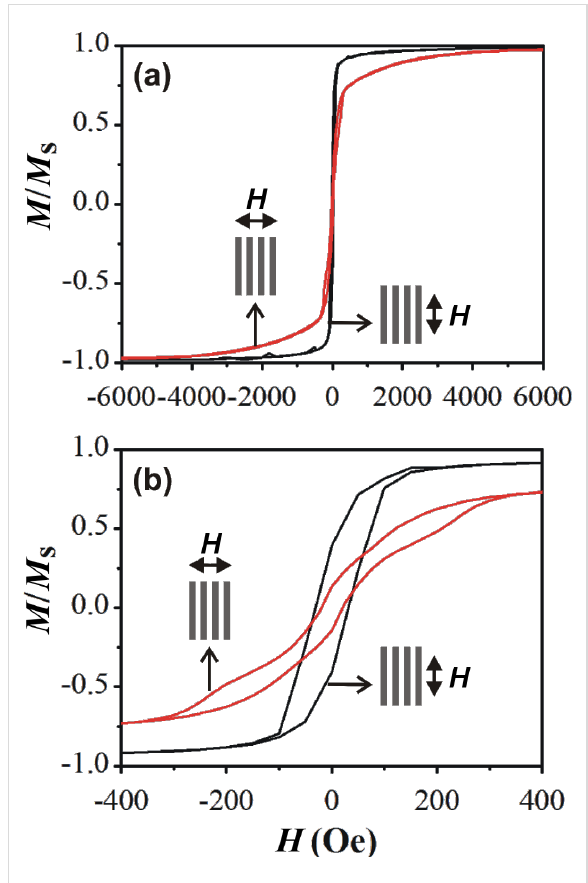
Figure 4: (a) Normalized hysteresis loops of the coaxial nanowire array measured at 300 K with an applied magnetic field parallel (black curve) and perpendicular (red curve) to the wire axis. Panel (b) is a magnified region of (a).